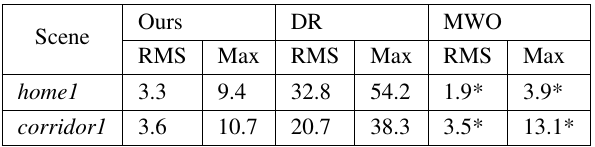
Table 1. Performance Comparison (unit: